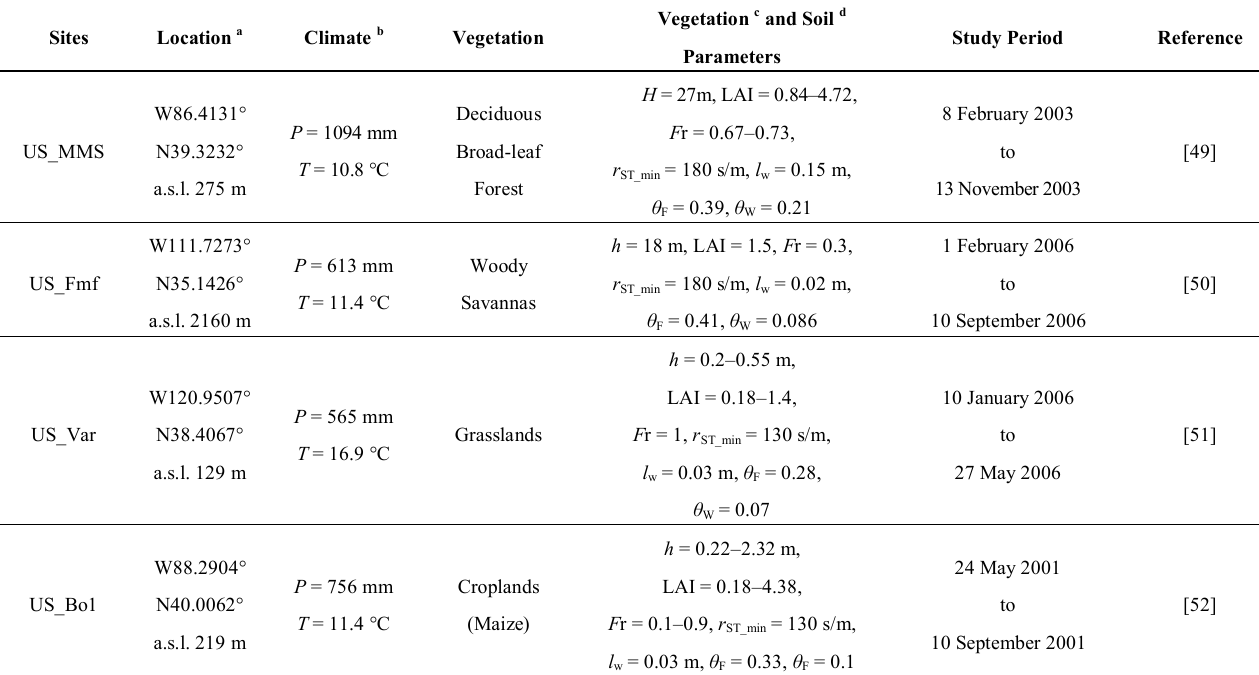
Table 1. General information of sites and selected model parameters used in this